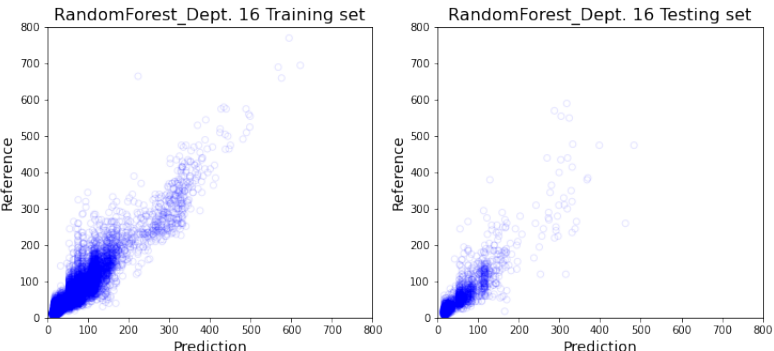
Figure A1. Model Performance of RandomForest on Dept.16. The visualization of training and testing data for department specific model on department 16 with Random Forest.